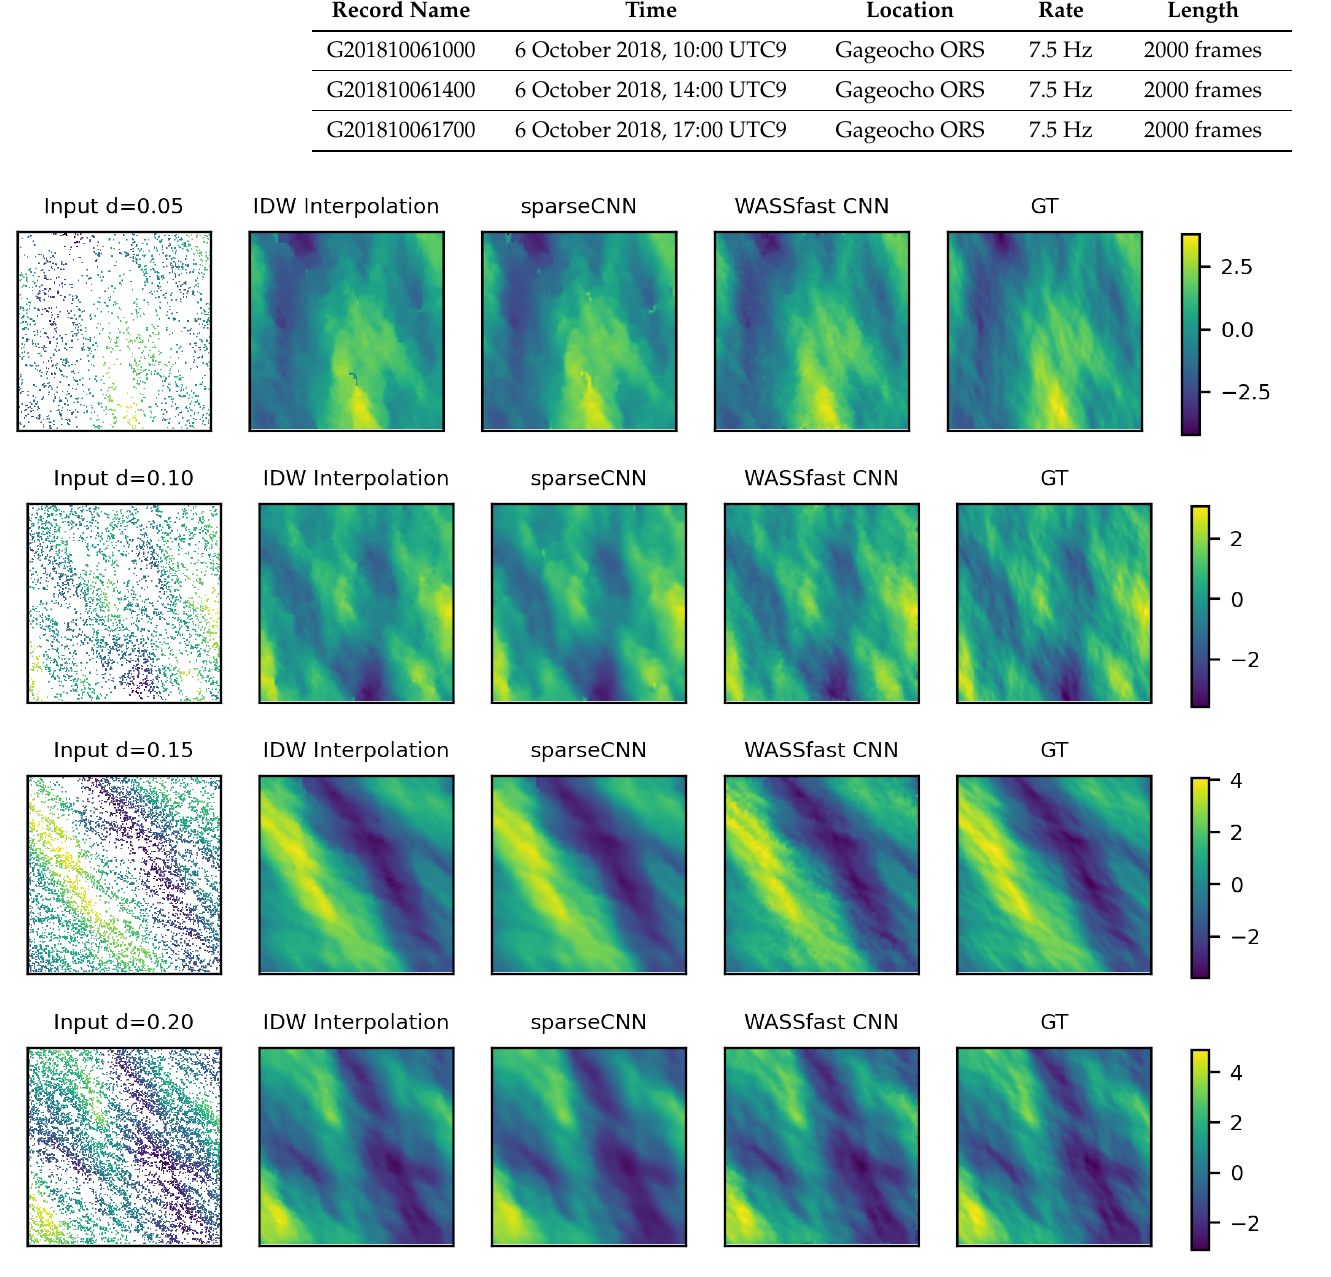
Figure 8. Qualitative result of our CNN for sea waves’ surface reconstruction. From left to right : sparse input data, IDW interpolation, output of depth completion, WASSfast CNN output O t , ground truth output ¯ O t . Each row shows a different scenario with an increasing sampling. Note how the full network output (with temporal combiner and an additional feed-forward CNN step) improves the reconstruction of the depth completion block alone (SparseCNN), especially at high frequencies. Colorbar is in